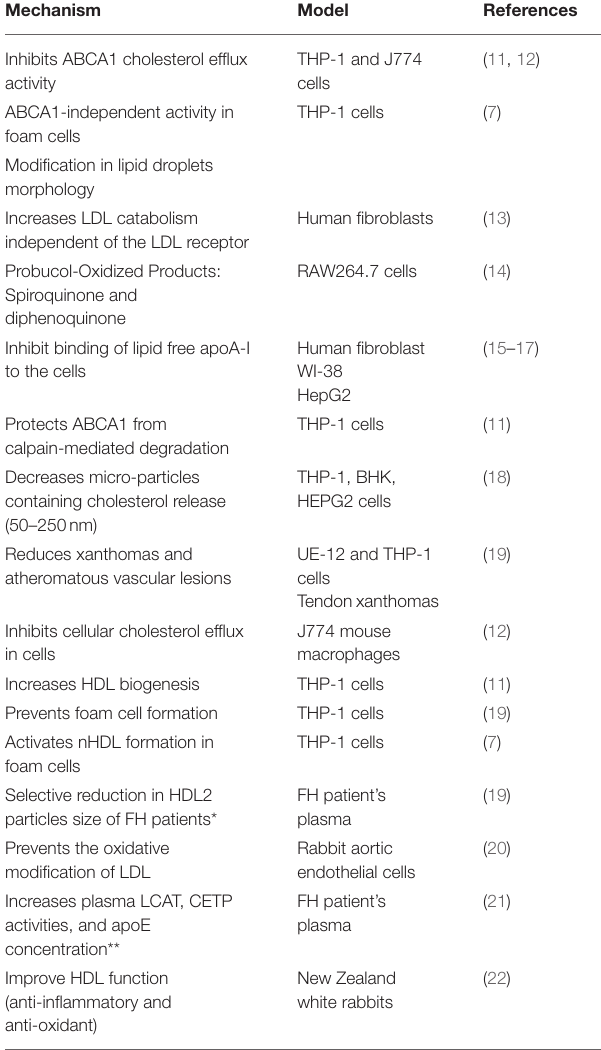
TABLE 1 | Summary of potential mechanisms of pharmacologic action of